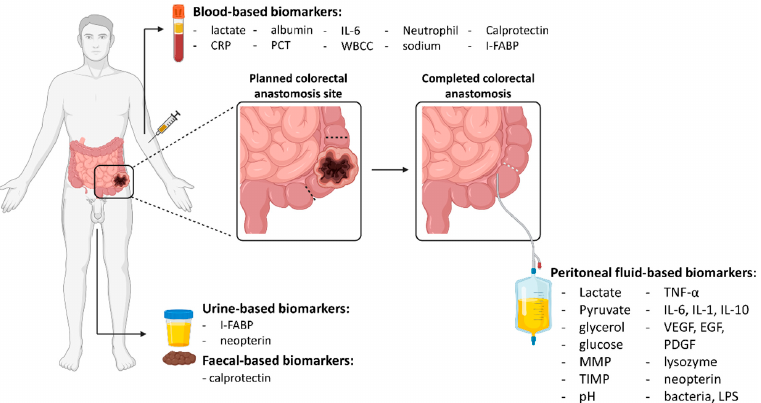
Figure 1. Patient samples used for biomarker assessment following a colorectal anastomosis in the treatment of colon cancer. (IL; interleukin, CRP; C-reactive protein, PCT; procalcitonin, WBCC; white blood cell count, I-FABP; intestinal fatty acid binding protein, MMP; matrix metalloproteinases, TIMP; tissue inhibitor of metalloproteinases, VEGF; vascular endothelial growth factor, EGF; epidermal growth factor, PDGF; platelet-derived growth factor, LPS; lipopolysaccharide). Figure created in Biorender.